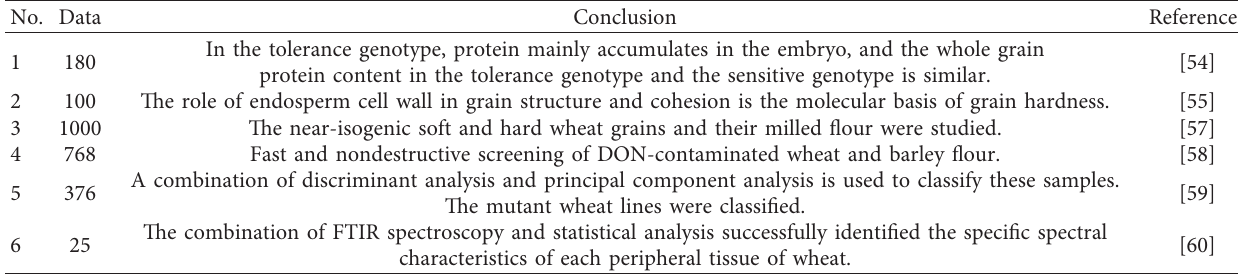
Table 4: Raman spectroscopy test of